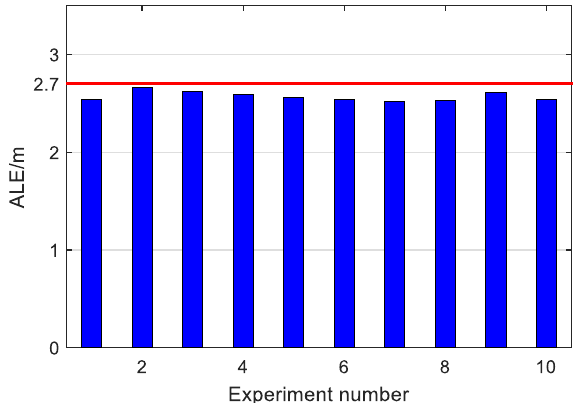
Figure 8. Experiments with random co-occurrence